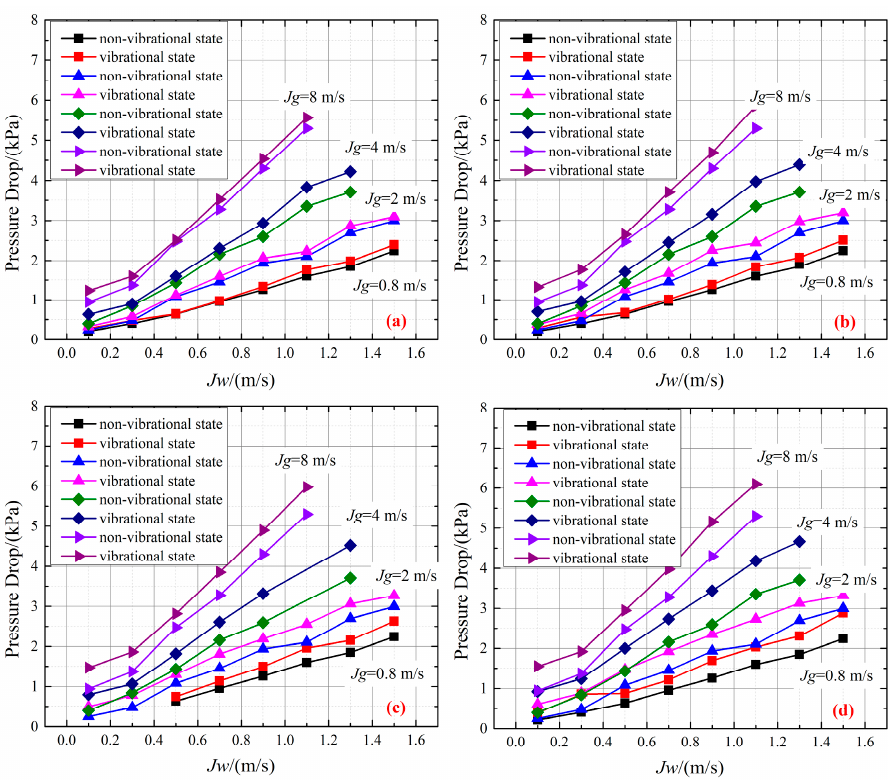
Figure 6. The pressure drop under vibrational state and non-vibrational state ( A = 62 mm): ( a ) H = 0.5 Hz, ( b ) H = 0.8 Hz, ( c ) H = 0.9 Hz, ( d ) H = 1.0 Hz.